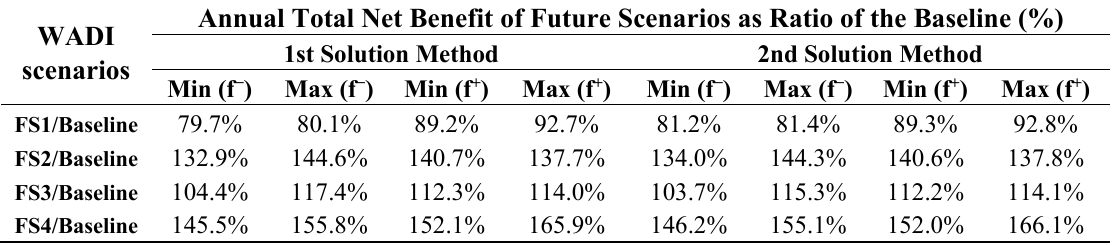
Table 23. Total annual net benefit (EUR) of the four future scenarios as ratio of the baseline (%).